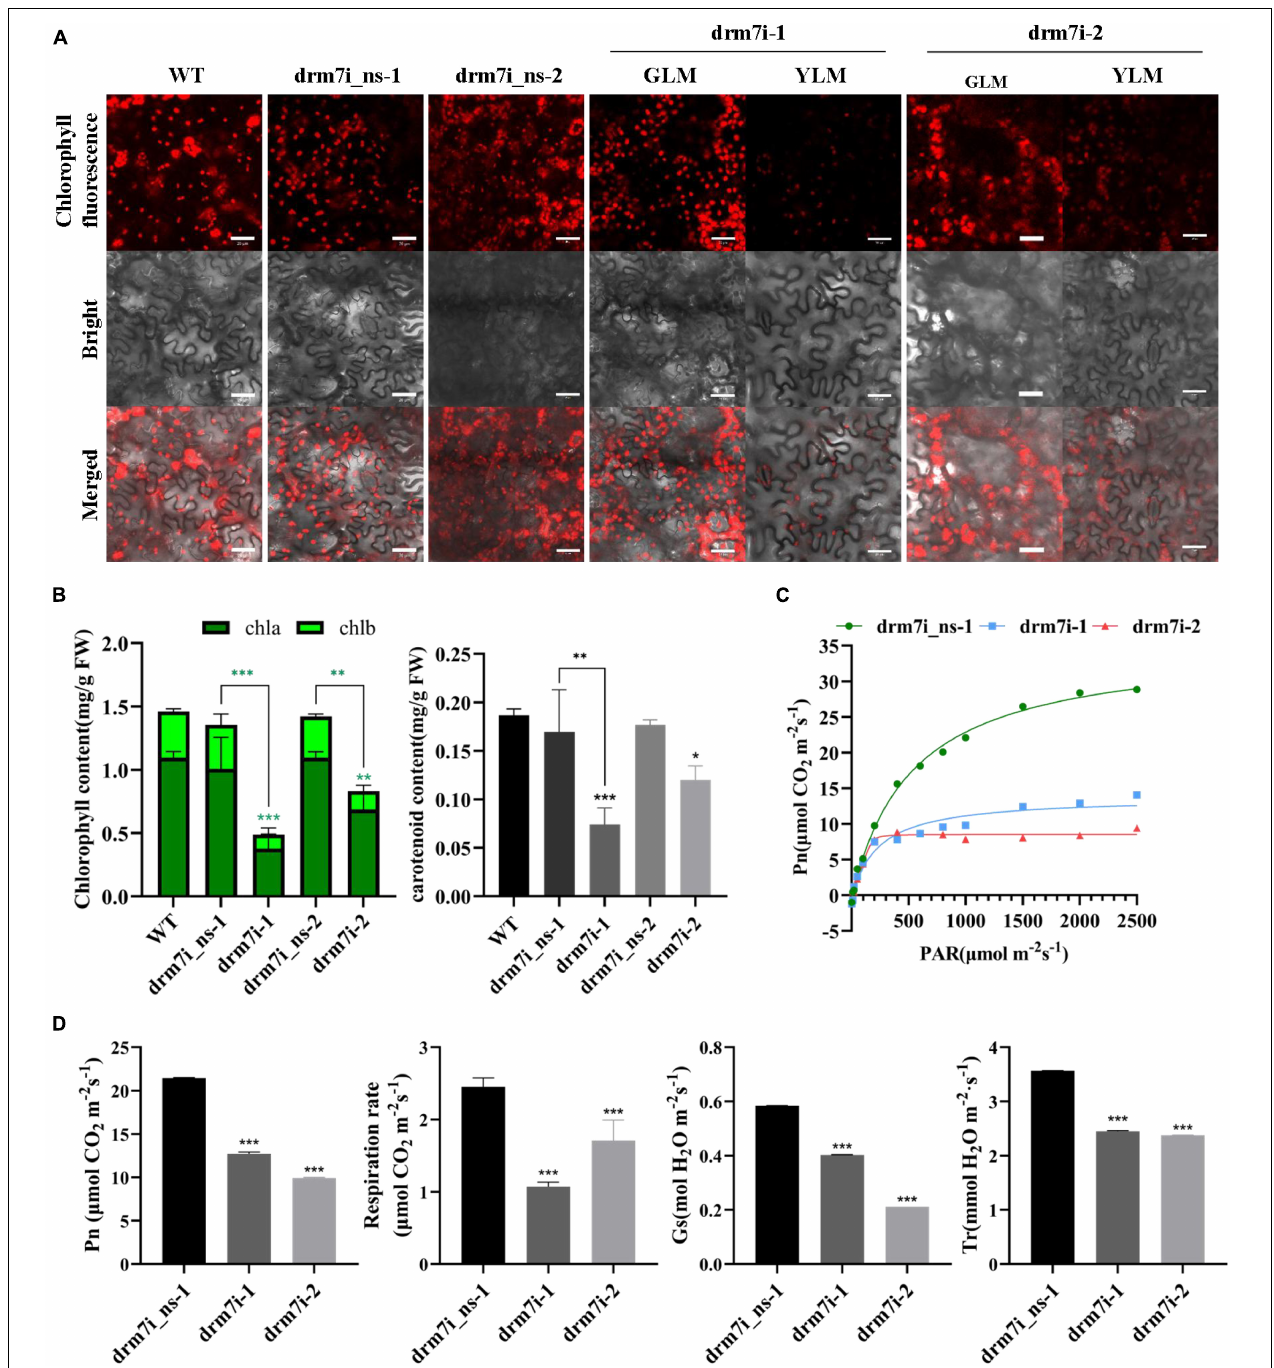
FIGURE 2 | Measurement of photosynthetic pigment content and photosynthetic capacity. (A) The auto-fluorescence of chlorophyll in leaves of SlDRM7 -RNAi lines. Strong chlorophyll auto-fluorescence intensity with almost no differences was observed in leaf Mesophyll cells from the 2nd compound leaves of wild-type AC (WT), two drm7i_ns lines, and the greening leaf Mesophyll (GLM) cells of two drm7i lines at the six-leaf stage, but much weaker in the yellowing leaf mesophyll (YLM) cells of two drm7i lines. WT, drm7i_ns-1 and drm7i_ns-2, drm7i-1 and drm7i-2 are shown. Bars = 20 µ m. (B) The content of three photosynthetic pigments in leaf tissues of SlDRM7 -RNAi lines. The content of chlorophyll a (chla) and chlorophyll b (chlb) (left panel), and carotenoid (right panel) was measured in the 2nd compound leaves of six-leaf-stage seedlings of WT, two drm7i_ns lines, and two drm7i lines, respectively. (C,D) Effect of SlDRM7 -RNAi on photosynthesis. Light and CO 2 response curves (C), as well as net photosynthetic rates (Pn), respiration rate, stomatal conductance (Gs), and transpiration rate (Tr) (D) of the 2nd compound leaves of six-leaf-stage seedlings of drm7i_ns-1 and two drm7i lines. Data are means ± SD ( n = 3 in panel B , while n = 5 in panel D ). Asterisks indicate the significant differences when compared with WT or drm7i_ns lines (* P ≤ 0.05, ** P ≤ 0.01, *** P ≤ 0.001, one-way ANOVA, Tukey’s HSD).